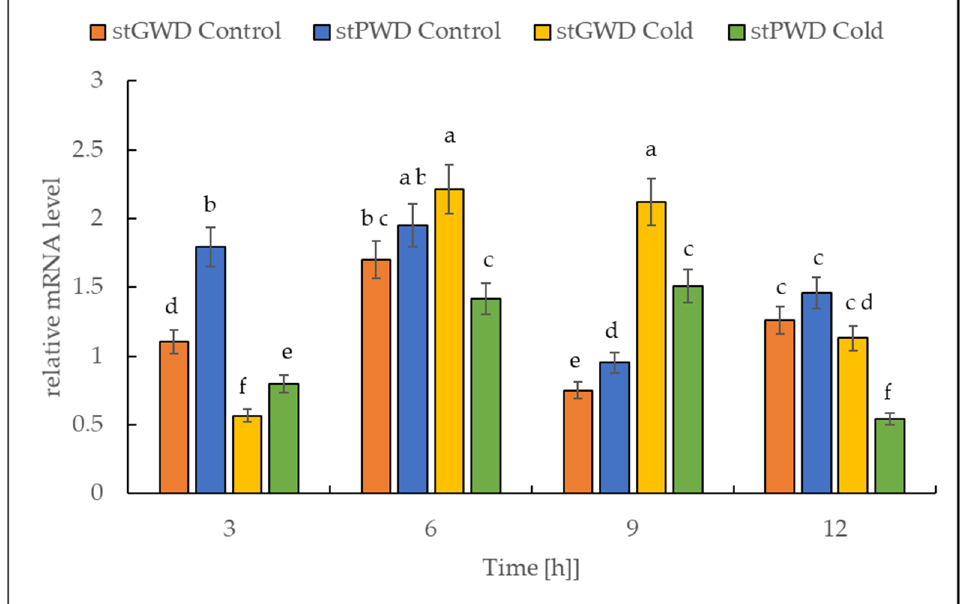
Figure 7. Effect of the low temperature on the expression level of the genes encoding for α -glucan, water dikinases and phosphoglucan, water dikinase in potato leaves. The results are the means of three replicates. Different letters at the top of the bars indicate significant differences, which were calculated ( p ≤ 0.05) according to Tukey’s HD post hoc test.